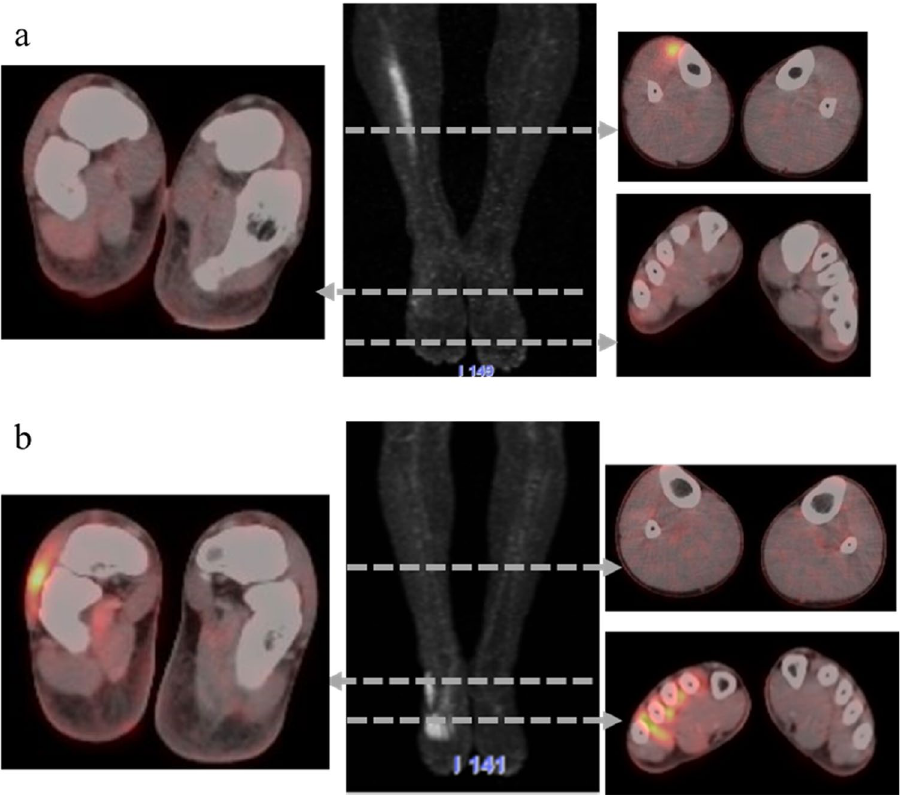
Figure 3. Representative lower-body positron emission tomography images after exercise performance. Positron emission tomography image and axial section of fusion computerized tomography from the foot rock- paper-scissors group ( a ) and the towel-gathering group ( b